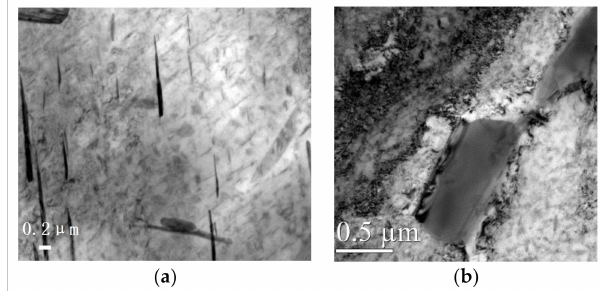
Figure 6. The main phase composition of GH4169. ( a ) γ -phase matrix, ( b ) δ phase. The appearance of DSA and DP (dynamic precipitation) on the surface of the material during WLSP would have an e ff ect on the microstructure and in turn improve its properties. By